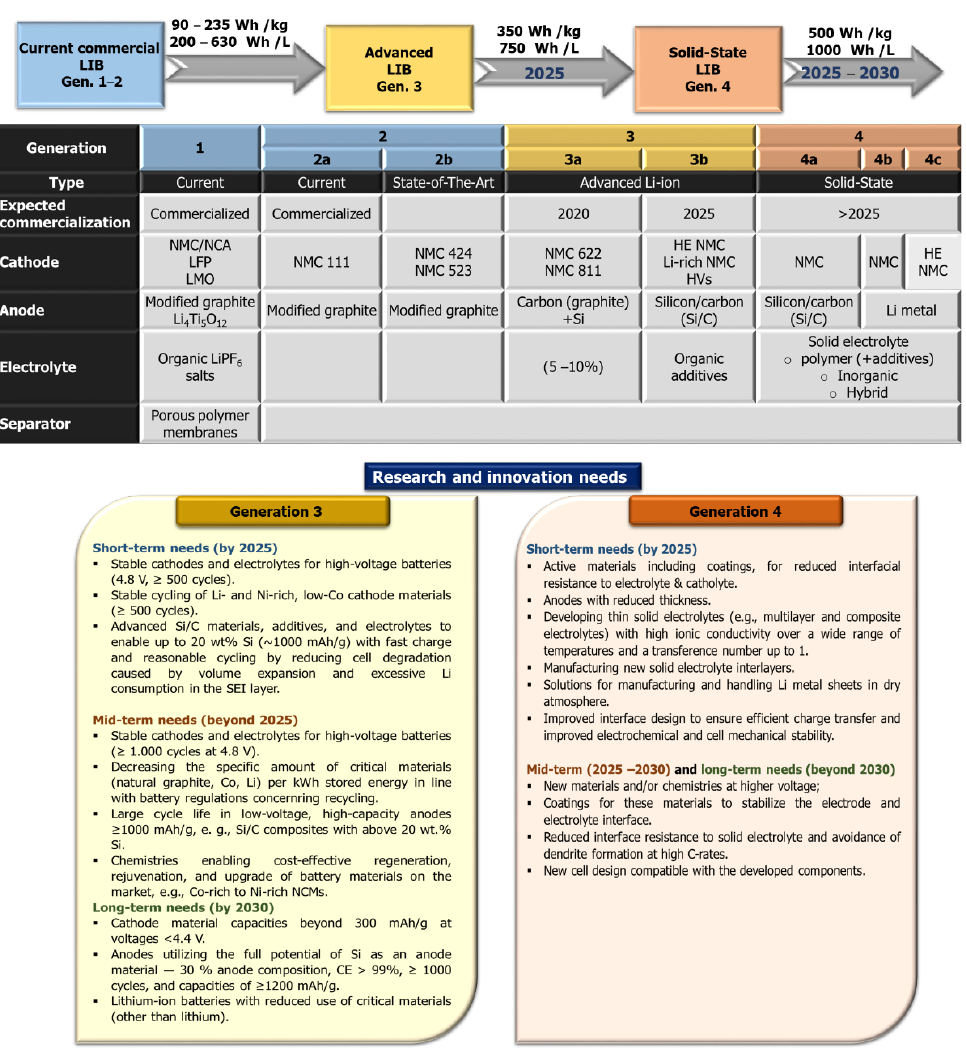
Figure 9. An overview of key recommendation of different Li-ion batteries generations for mobility along with short- and long-term research needs.